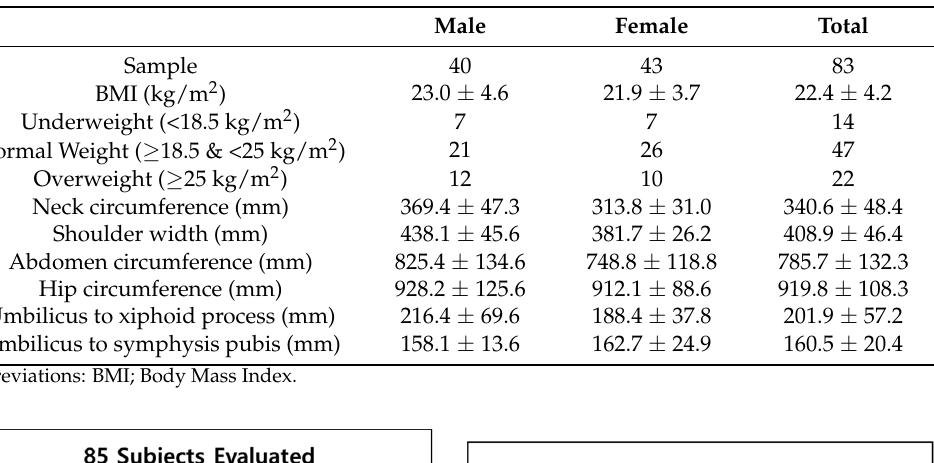
Table 1. Characteristics of the study population.